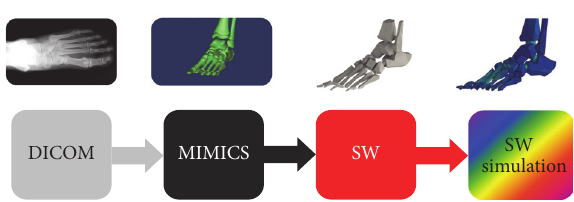
Figure 1: Solid models of bony tissue, soft tissue, and typical insole rendered from real CT-Scan images in a CAD software (SolidWorks), schematic